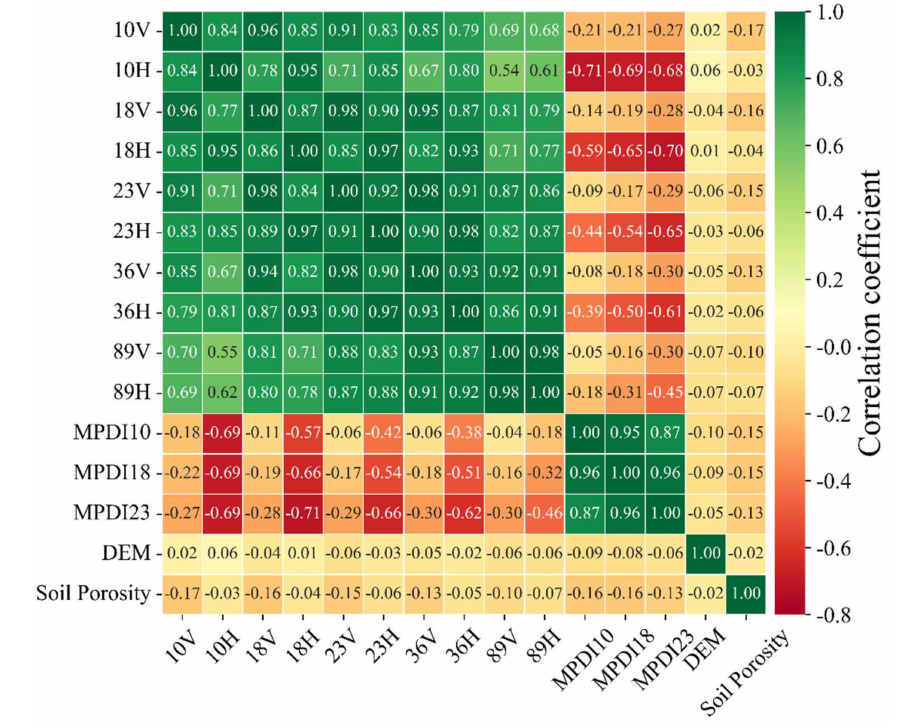
Figure 3. Correlation coefficient between variables in the training datasets from OCD (upper left triangle) and RCD (lower right triangle).